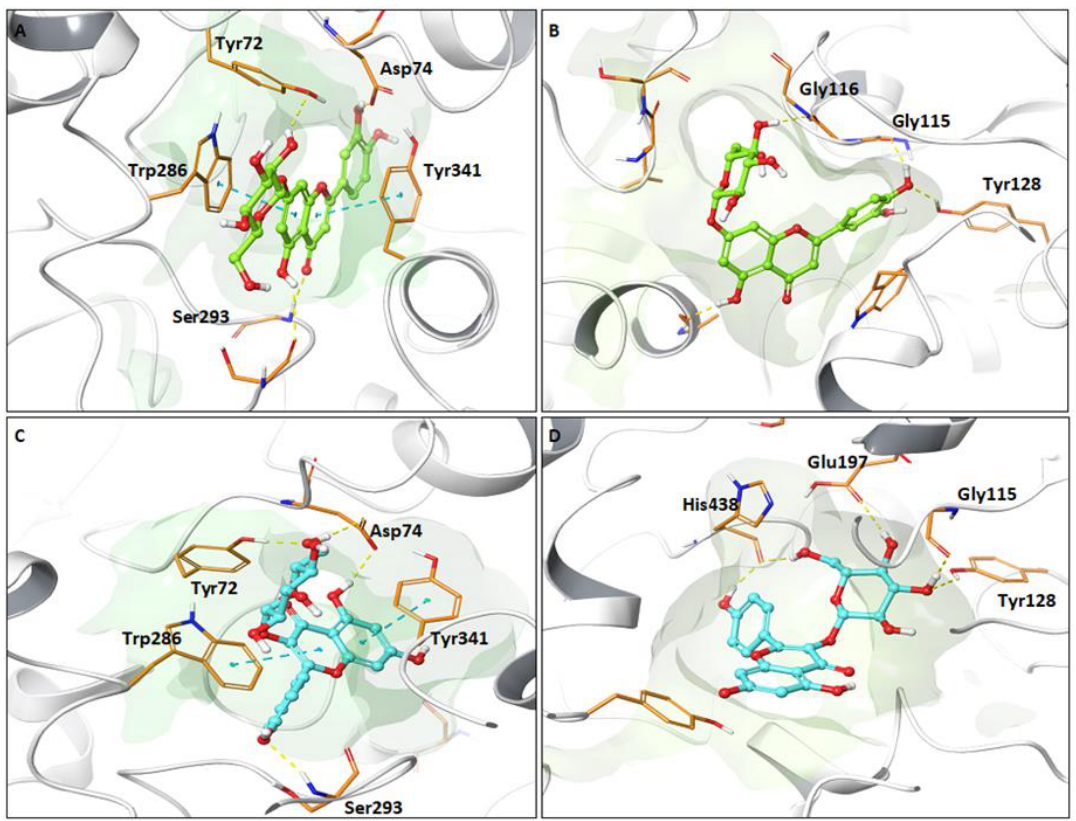
Figure 2. Predicted binding modes for some studied compounds within the AChE and BChE active sites. ( A ) Luteolin-7- O -glucoside is shown in ball-and-stick representation with green carbons within AChE and ( B ) BChE active site. ( C ) Kaempferol-3- O -glucoside is shown in ball-and-stick representation with cyan carbons within AChE and ( D ) BChE active site. Relevant amino acids are shown in the tubes in orange. The secondary protein structure is depicted as white ribbons. Cyan dotted lines represent π - π stacking interaction between ligands and AChE/BChE residues. Yellow dotted lines represent hydrogen bond interaction between ligands and AChE/BChE residues. Table 3. Binding energy of enzyme – ligand complexes.